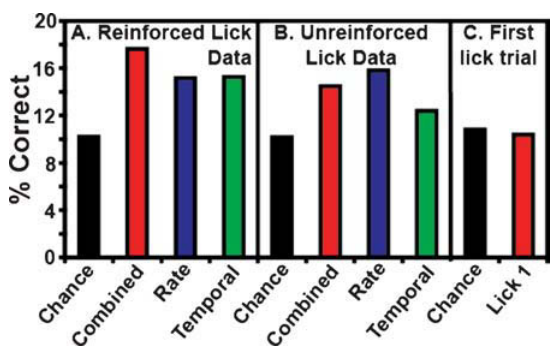
Figure 3. Total ensemble predictions. This figure depicts the total ensemble predictionsforalltastantsandtheirconcentrations.Thepercentageofcorrectly identified taste trials is given on the ordinate. (A) This panel represents tastant predictions for the reinforced lick data. The weighted chance prediction rate is shown in black. The combined model is depicted in red, and the rate and temporal models are given in blue and green, respectively. These conventions are employed for all subsequent figures. Here it is seen that all three model types predict tastants above chance, but the combined model demonstrates the highest prediction level. (B) This panel depicts the tastant predictions as a function of the unreinforced lick data. Again, all three models perform well abovechance,buttheratemodelexhibitsthebestperformance. (C) Thispanel shows the first unreinforced lick trial (Lick 1) before the start of a tastant block.